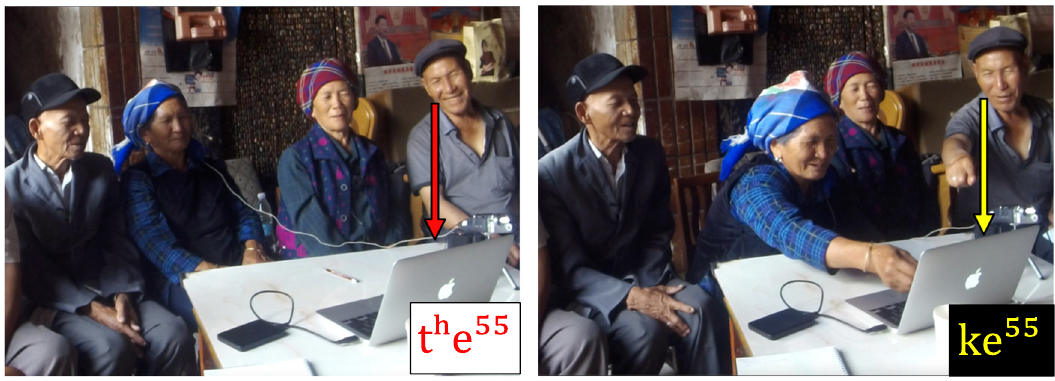
Figure 14: LJF ( rightmost speaker ) uses the addressee deictic t ʰ e ⁵⁵ in Example 23 without producing any gestures. Then, he points at the screen while producing the distal deictic ke ⁵⁵